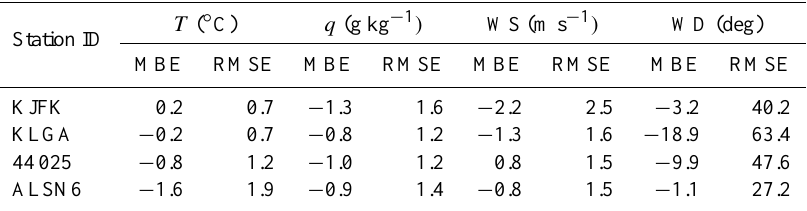
Table 3. Statistics from the comparison of WRF-Chem simulated meteorology with measurements from four surface meteorological stations. Positive values of MBE in wind direction stand for a clockwise bias from the observed wind